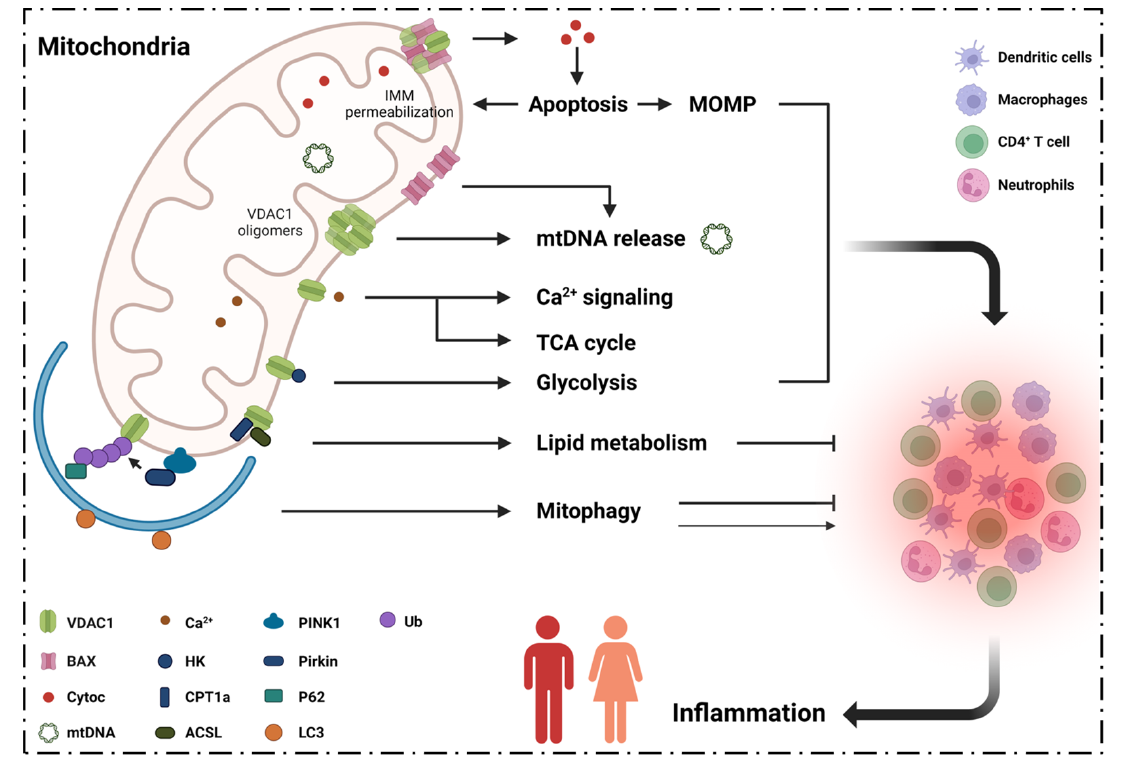
Figure 1. VDAC1 regulates inflammatory pathogenesis. Mitochondria are the center of energy generation, the TCA cycle, glycolysis and lipid metabolism. VDAC1 is the fundamental component that maintains mitochondrial function. VDAC1 plays an important role in the regulation of apoptosis, mtDNA release, Ca 2+ signaling, TCA cycle, glycolysis, lipid metabolism and mitophagy. Impaired mitochondrial homeostasis with dysfunctional signal networks results in inflammatory pathogenesis and mitochondrial diseases. Abbreviations: ACSL: long-chain acyl-CoA synthase; BAX: Bcl-2-associated X protein; CPT1a: carnitine palmitoyltransferase 1A; Cyto c: cytochrome c; HK: hexokinase; LC3: microtubule-associated proteins 1A/1B light chain 3; IMM: inner mitochondrial membrane; MOMP: mitochondrial outer membrane permeabilization; mtDNA: mitochondrial DNA; PINK1: PTEN-induced putative kinase 1; TCA cycle: tricarboxylic acid cycle; Ub: ubiquitin; VDAC1: voltage-dependent anion channel 1.